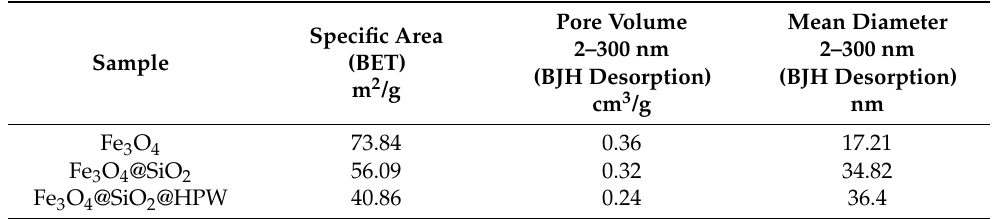
Table 3. Textural characteristics of the bare Fe 3 O 4 , Fe 3 O 4 @SiO 2 support, and Fe 3 O 4 @SiO 2 @HPW